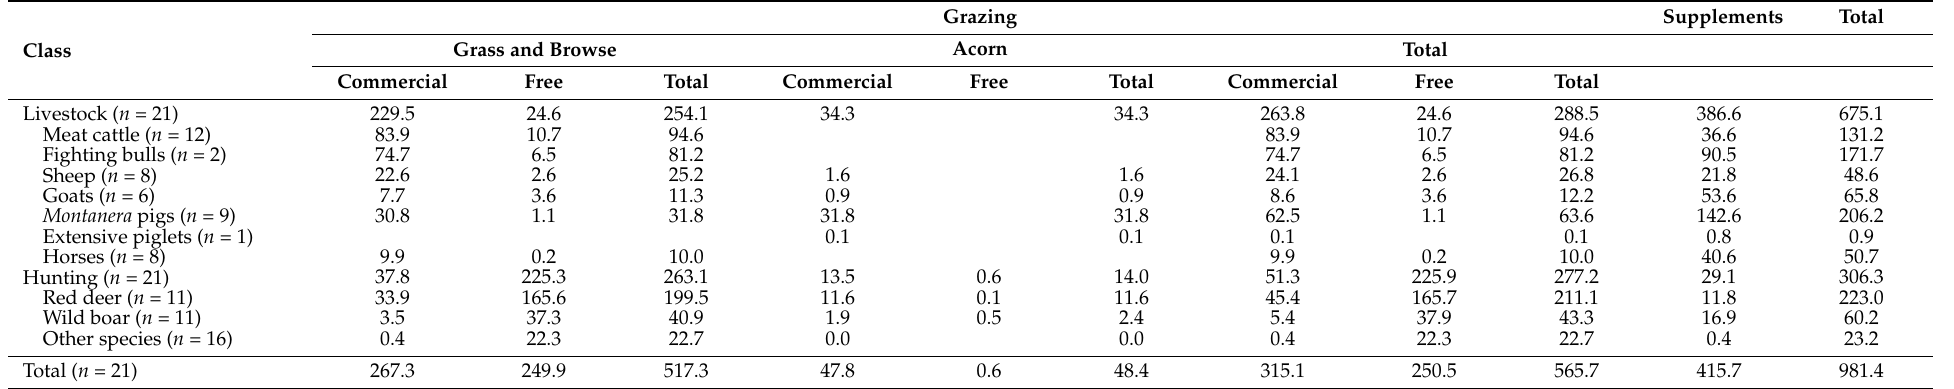
Table A1. Livestock and game species grazing and supplement consumption of large privately owned dehesas in Andalusia (2010: FU/ha).